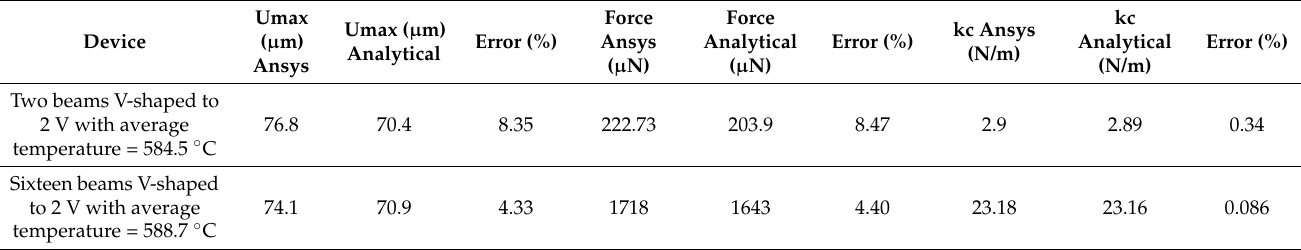
Table 6. Parameter results for V-shaped